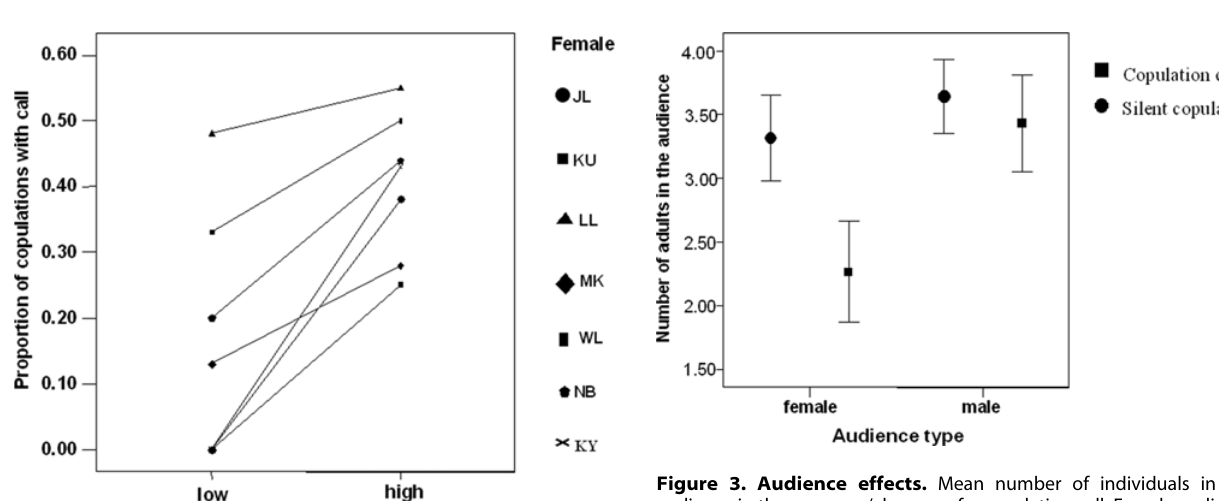
Figure 3. Audience effects. Mean number of individuals in the audience in the presence/absence of a copulation call. Female audience (N females =5, N copulations =90): the number of adult females present. Male audience (N females =7, N copulations =126): the number of adult males present. Error bars represent Mean + 2 1 SE.